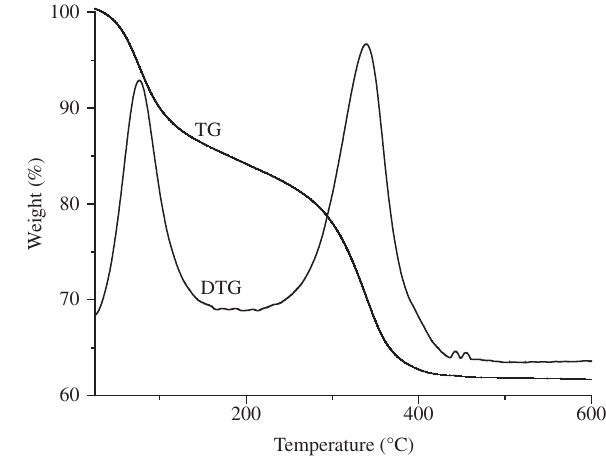
Figure 5. TG curve and DTG of TiO